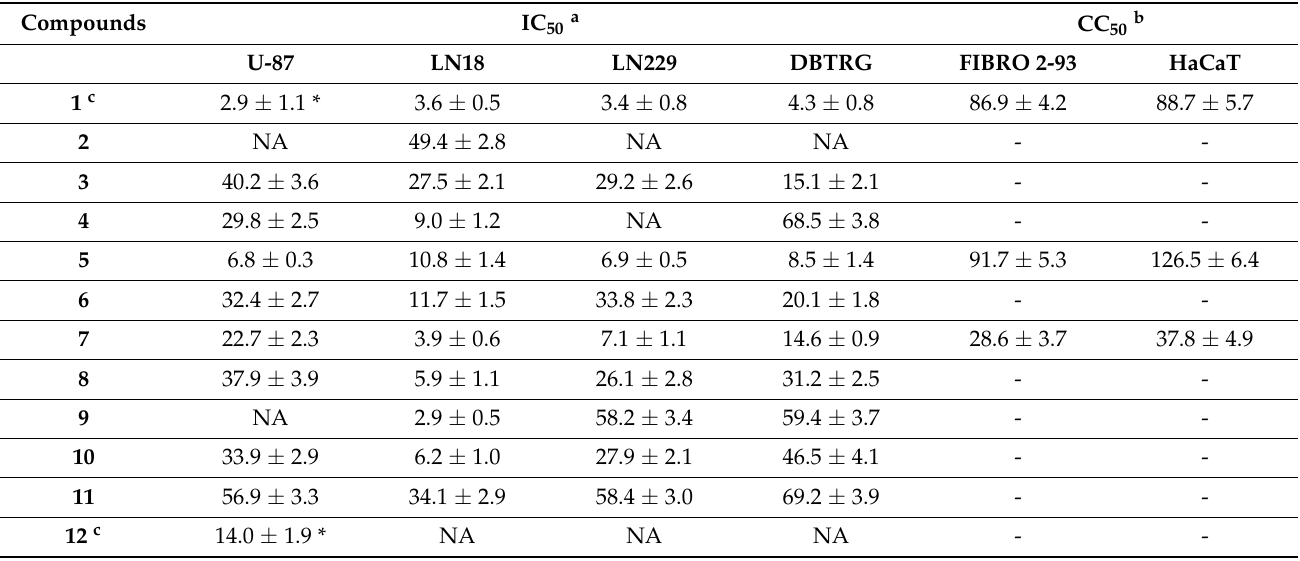
Table 2. Antiproliferative activity ( µ M) of compounds 1 – 12 against four GBM cell lines and cytotoxi- city ( µ M) of the most promising ones on nontumoral, healthy FIBRO 2-93 and HaCaT cell